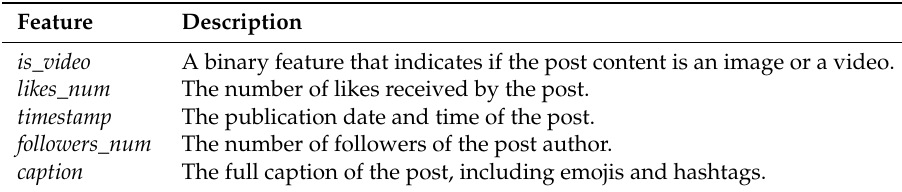
Table 1. Dataset features collected from Instagram.